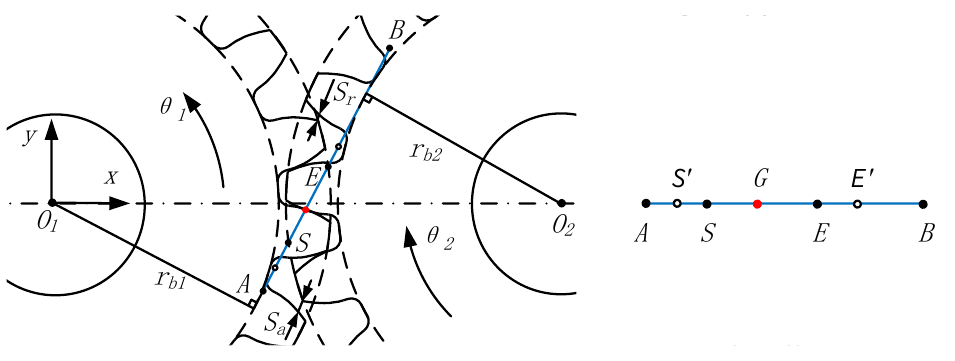
F t k 2 Figure 1. Mechanical model of plastic gear tooth. 2.2.2. Tooth Deflection Considering the Extended Tooth Contact Effect As plastic gears have a relatively low modulus, the tooth deflections can be large compared to those experienced by metal gears. Further, the flexibility of non-metallic gears allows for gear tooth contact outside the theoretical line of action. Figure 2 shows the mesh analysis model of a spur gear pair without tooth modification, where 1 is the driving gear, 2 is the driven gear, and 𝑟 𝑏𝑗 is the base radius of gear j . The generalized displacement of the gear pair can be expressed as: